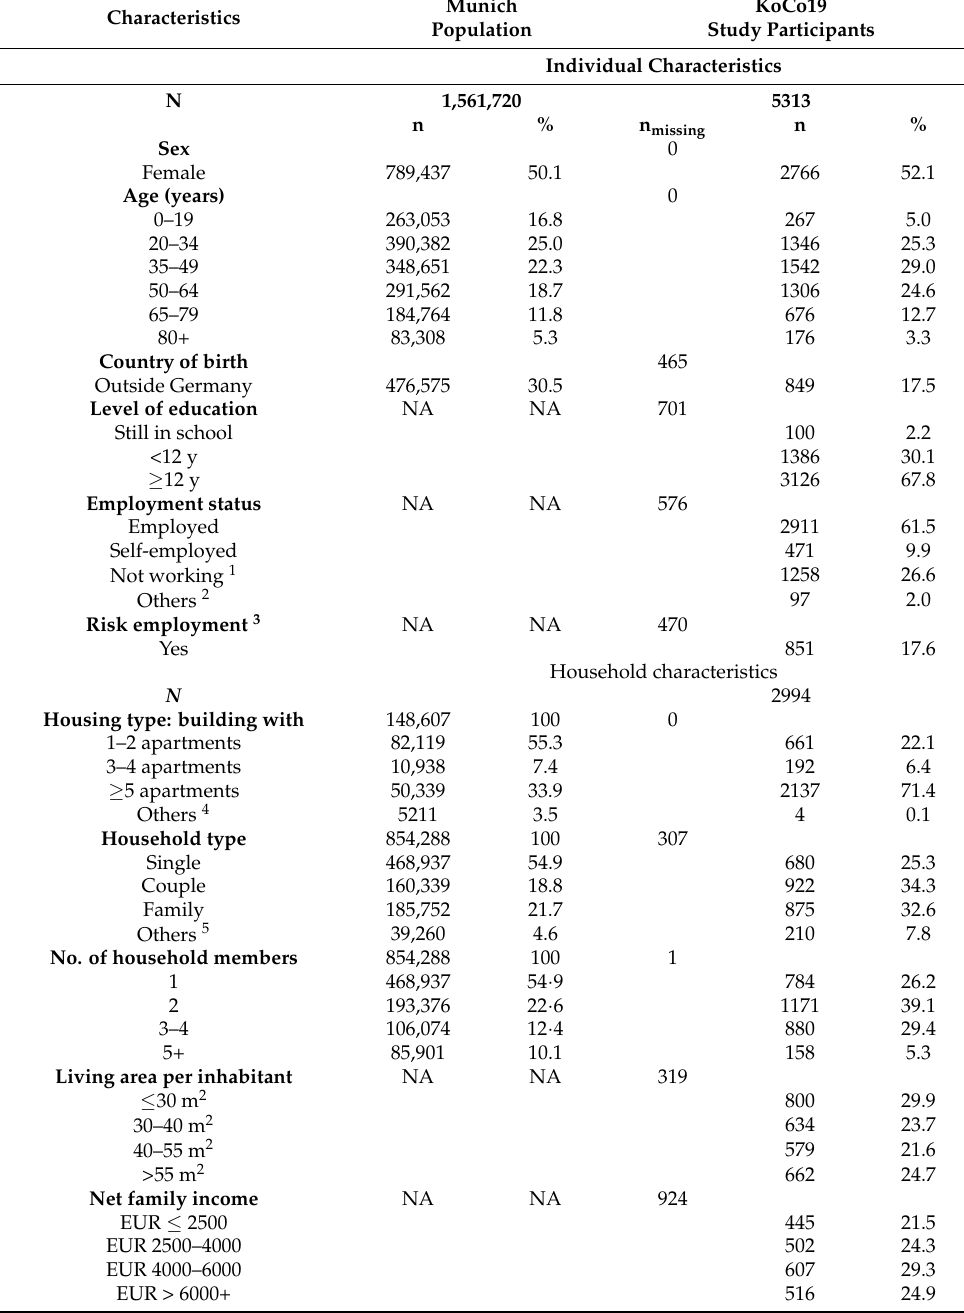
Table 1. Individual and household characteristics of the KoCo19 study participants compared to the Munich